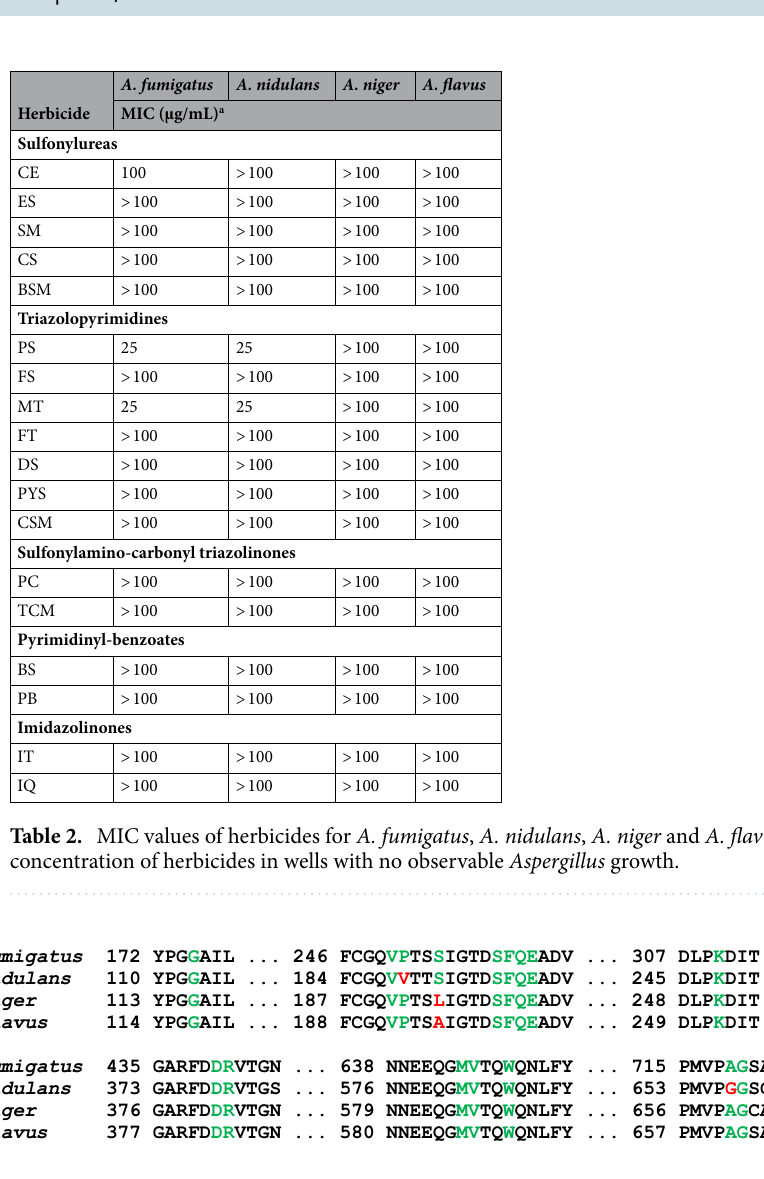
Figure 6. Partial alignment of A. fumigatus , A. nidulans , A. niger and A. flavus AHAS sequences highlighting the herbicide binding site residues. Herbicide binding site residues are identified by red or green text to indicate variable or identical sequences,